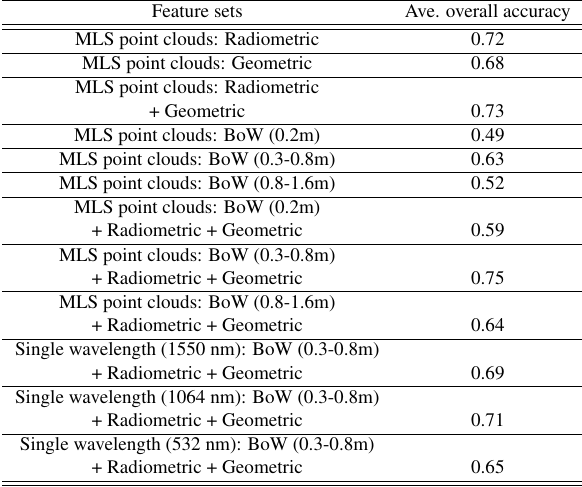
Table 1. Results of tree species classification.